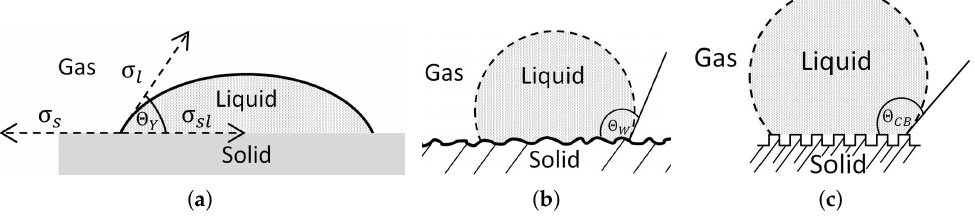
Figure 1. ( a ) three-phase contact line by Young [7]; ( b ) ‘Wenzel state’ [13]; ( c ) ‘Cassie–Baxter state’